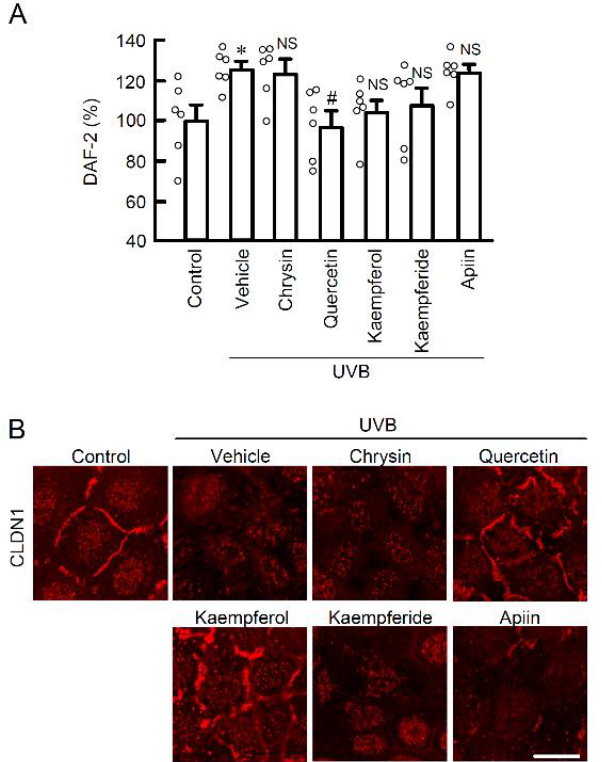
Figure 5. The effects of apigenin-like flavonoids on NO production and localization of CLDN1 in the weak UVB exposed cells. ( A ) After exposing the cells to weak UVB, the cells were incubated for 3 h in the absence (vehicle) and presence of 10 µ M chrysin, 10 µ M quercetin, 10 µ M kaempferol, 10 µ M kaempferide, or 10 µ M apiin. The cells were incubated with 5 µ M DAF-2DA for 30 min. The fluorescence intensity of DAF-2 was measured using a fluorescent microplate reader. n = 6. * p < 0.05 vs. control. # p < 0.01 and NS p > 0.05 vs. vehicle. ( B ) Representative images of immunocytochemistry using anti-CLDN1 antibody. Scale bar indicates 10 μm.